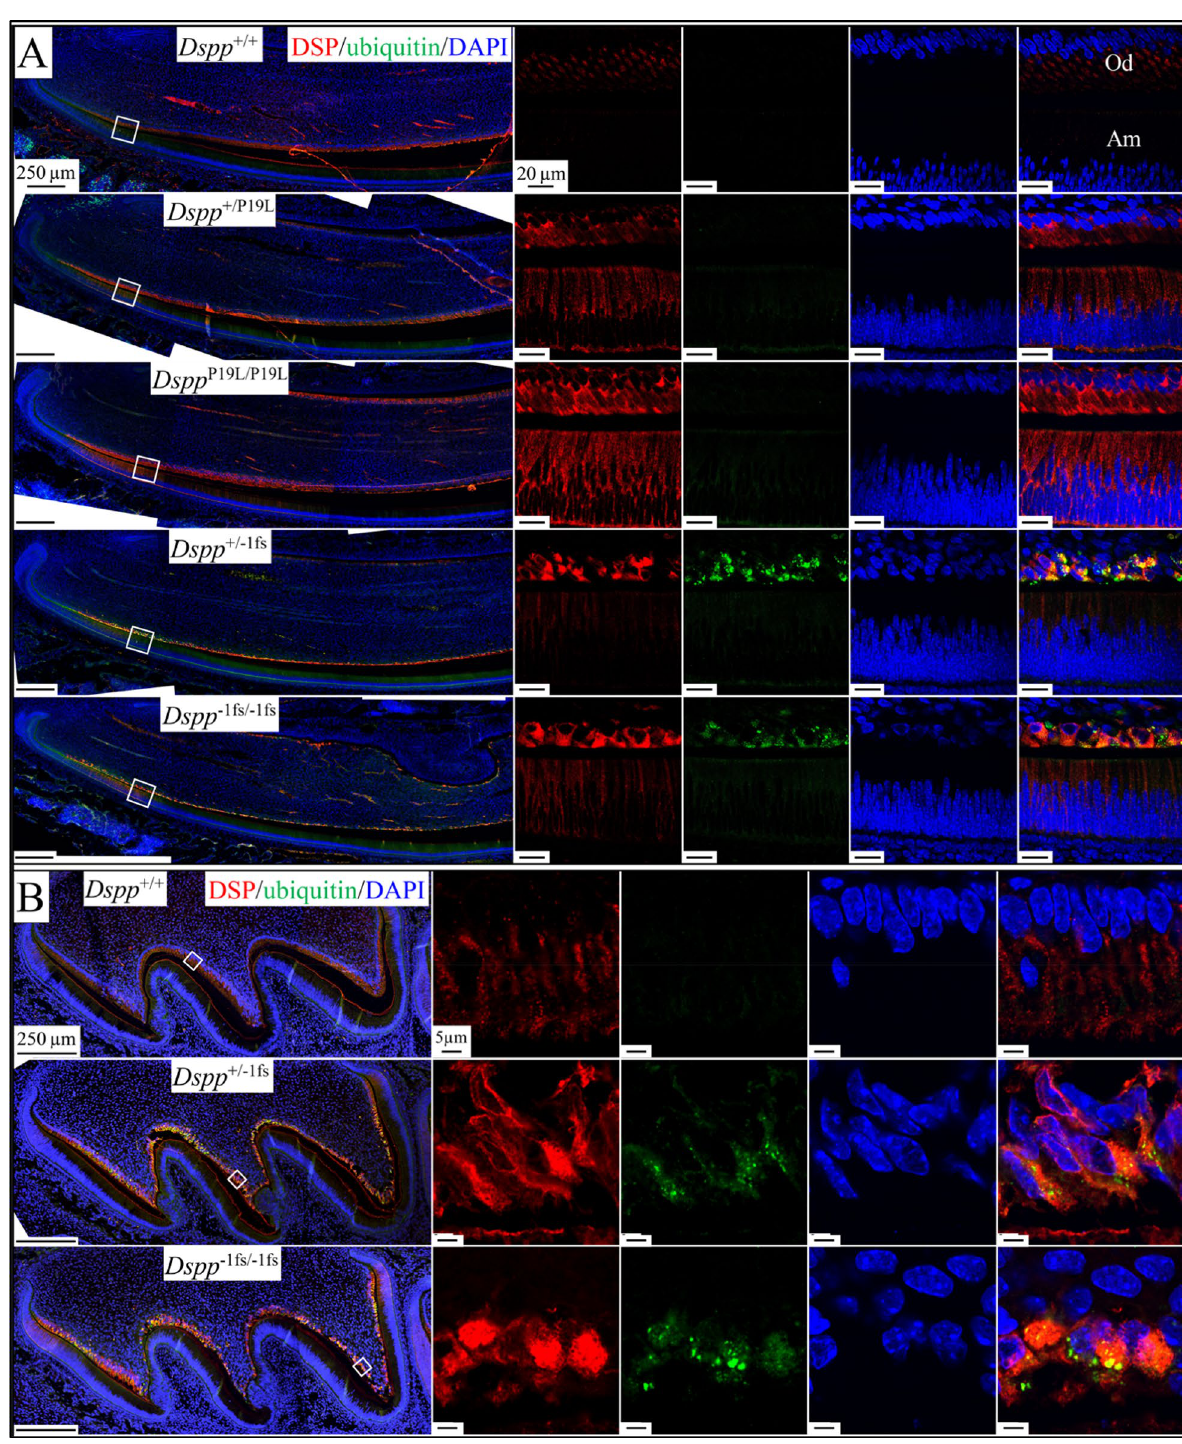
Figure 7. Activated ubiquitin activity in the odontoblasts of Dspp −1fs mice. Immunohistochemistry on D14 mandibular incisors ( A ) and D3 maxillary 1st molars ( B ), showing DSP (red), ubiquitin (green), and DAPI (blue; nucleus). Strong ubiquitin signal that partially overlapped the DSP signal was specifically detected in Dspp −1fs incisor ( A ) and molar ( B ) odontoblasts (Od). Ubiquitin signal was trace or not detected in odontoblasts or ameloblasts (Am) in Dspp +/+ and Dspp P19L incisors ( A ) or in Dspp −1fs ameloblasts ( B ). Scale bars: 250 μm (left)/5 μm